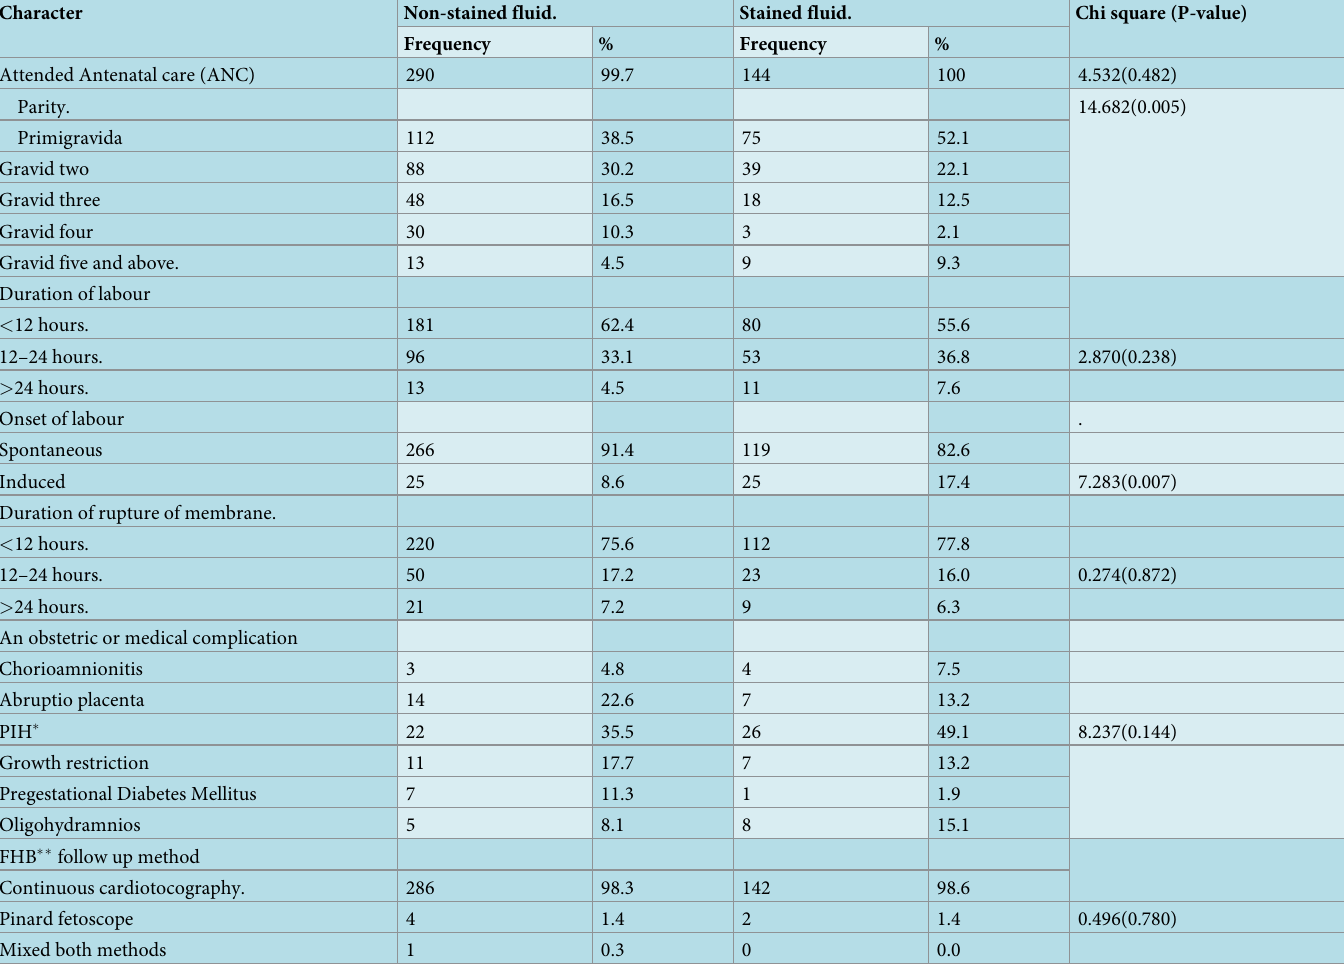
Table 2. Antepartum and intrapartum events of laboring mothers at SPHMMC from July 1 to December 30, 2018.